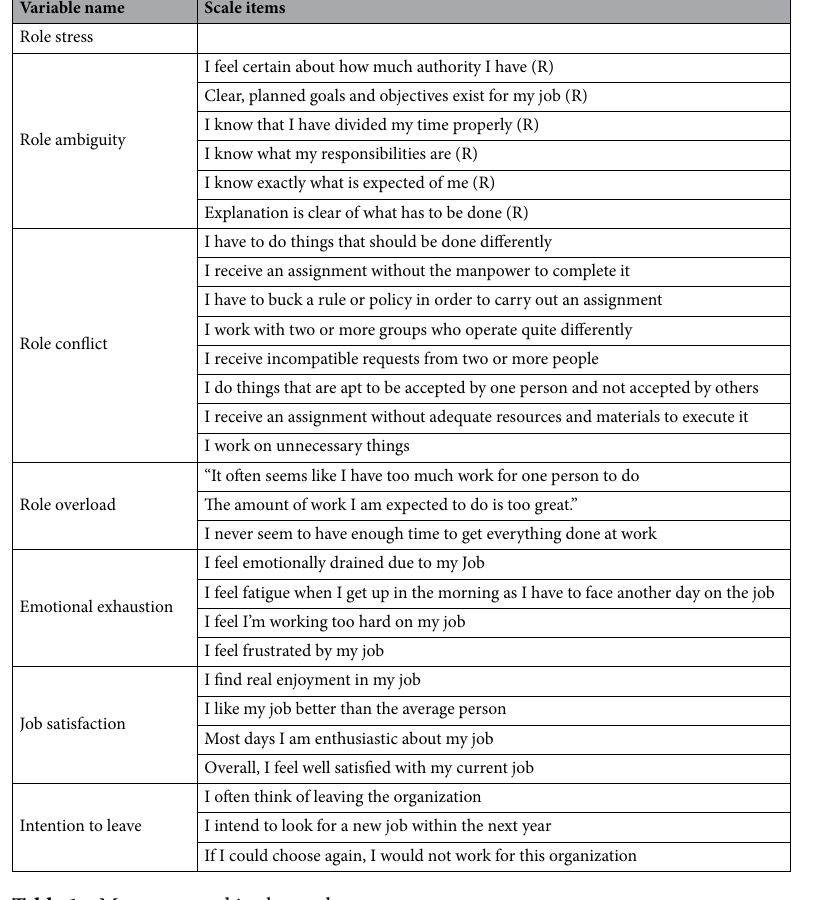
Table 1. Measures used in the